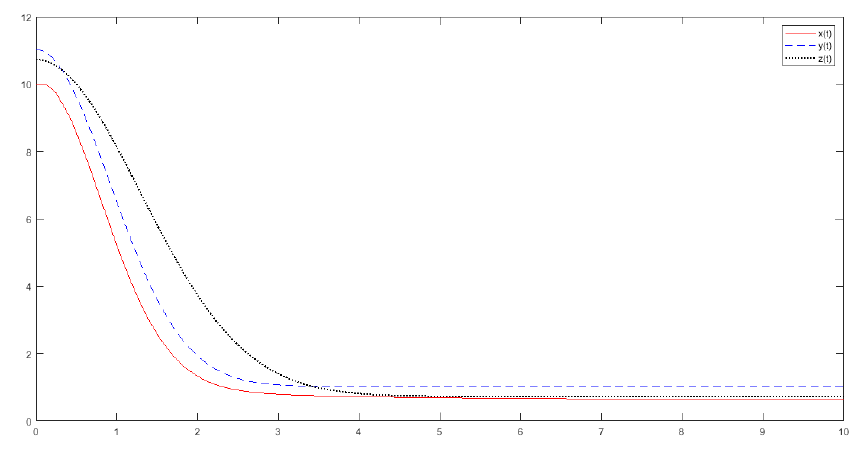
Figure 3. The graph of function x ( t ) , y ( t ) and z ( t ) (Example 1).